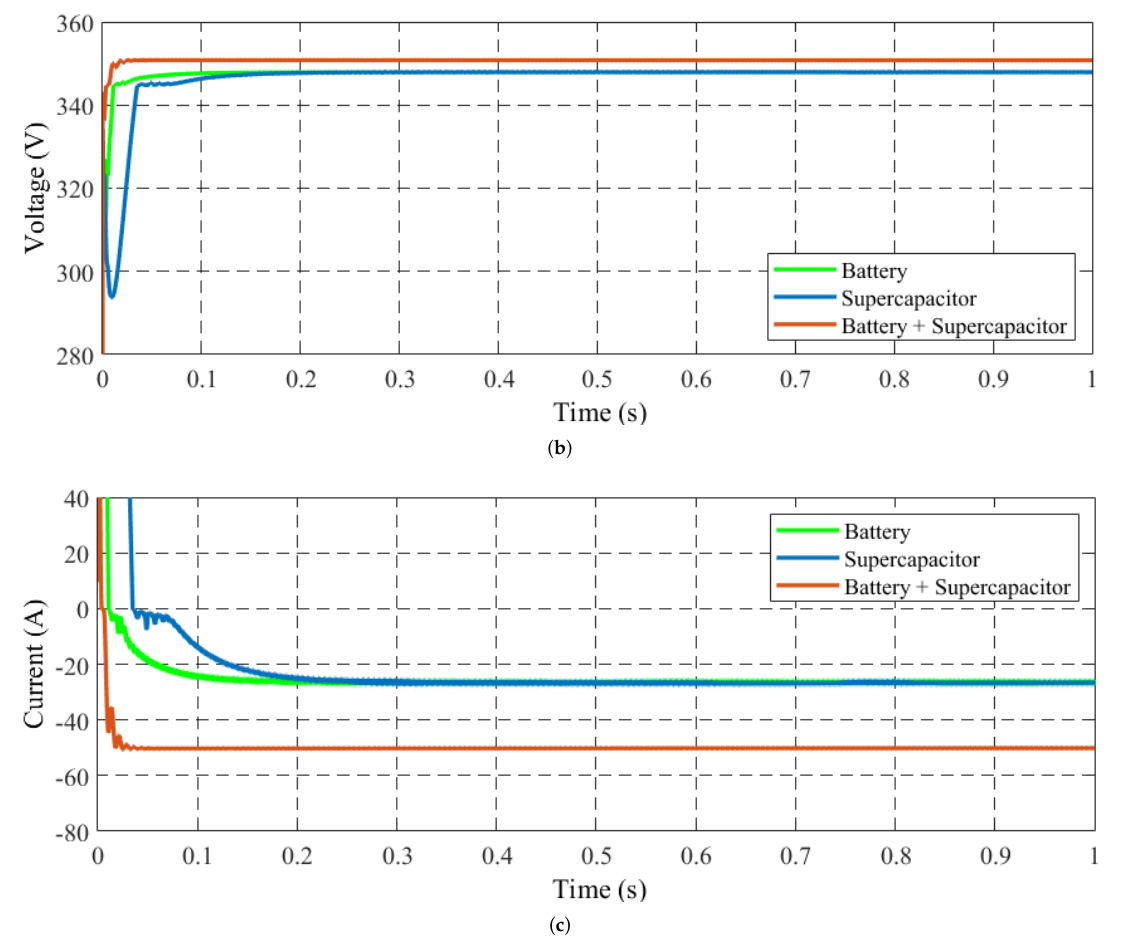
Figure 10. ( a ) State of Charge, ( b ) voltage, and ( c ) current profile of EV’s battery charging using battery, supercapacitor and battery +